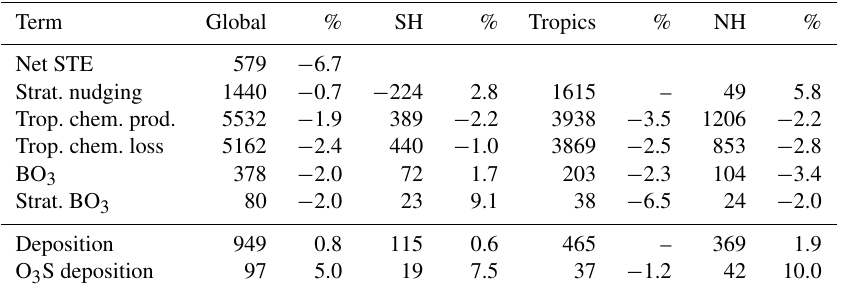
Table 4. The tropospheric chemical budget terms and burden for O 3 during 2006 for the 1 ◦ × 1 ◦ simulation, with all quantities being given in Tg O 3 yr − 1 . The associated percentage changes are given when comparing against the 3 ◦ × 2 ◦ simulation (equal to (1 ◦ × 1 ◦ ) – (3 ◦ × 2 ◦ ) / 3 ◦ × 2 ◦ ). The definition of the chemical tropopause and the calculation of the STE are calculated using the methodology outlined in Stevenson et al. (2006). The stratospheric nudging term refers to total change in the mass of O 3 in the stratospheric column when constraining zonal distributions to observational values from the MSR (Huijnen et al., 2010). The contributions to each term from the SH extra-tropics/tropics/NH extra-tropics regions (defined as 90–30 ◦ S/30 ◦ S–30 ◦ N/30–90 ◦ N) are